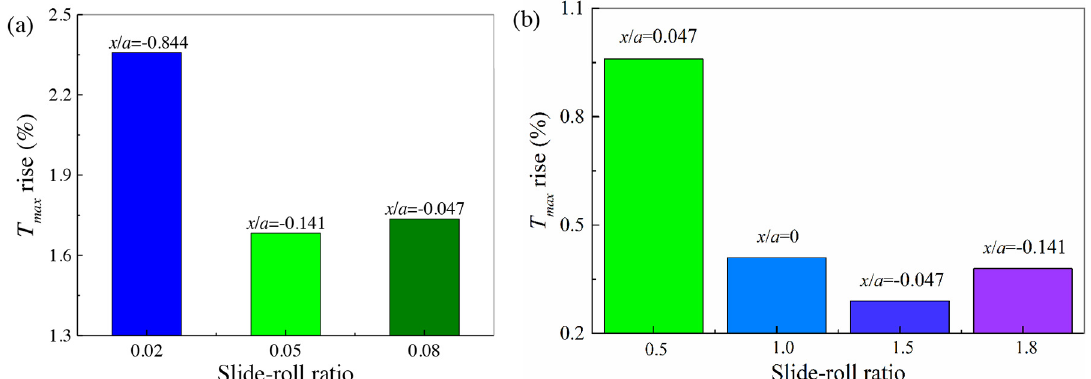
Fig. 15. Relative percentage rise of maximum temperature with inertia force at varied slide-roll ratio s : (a) for small slide-roll ratio, and (b) for large slide-roll ratio.